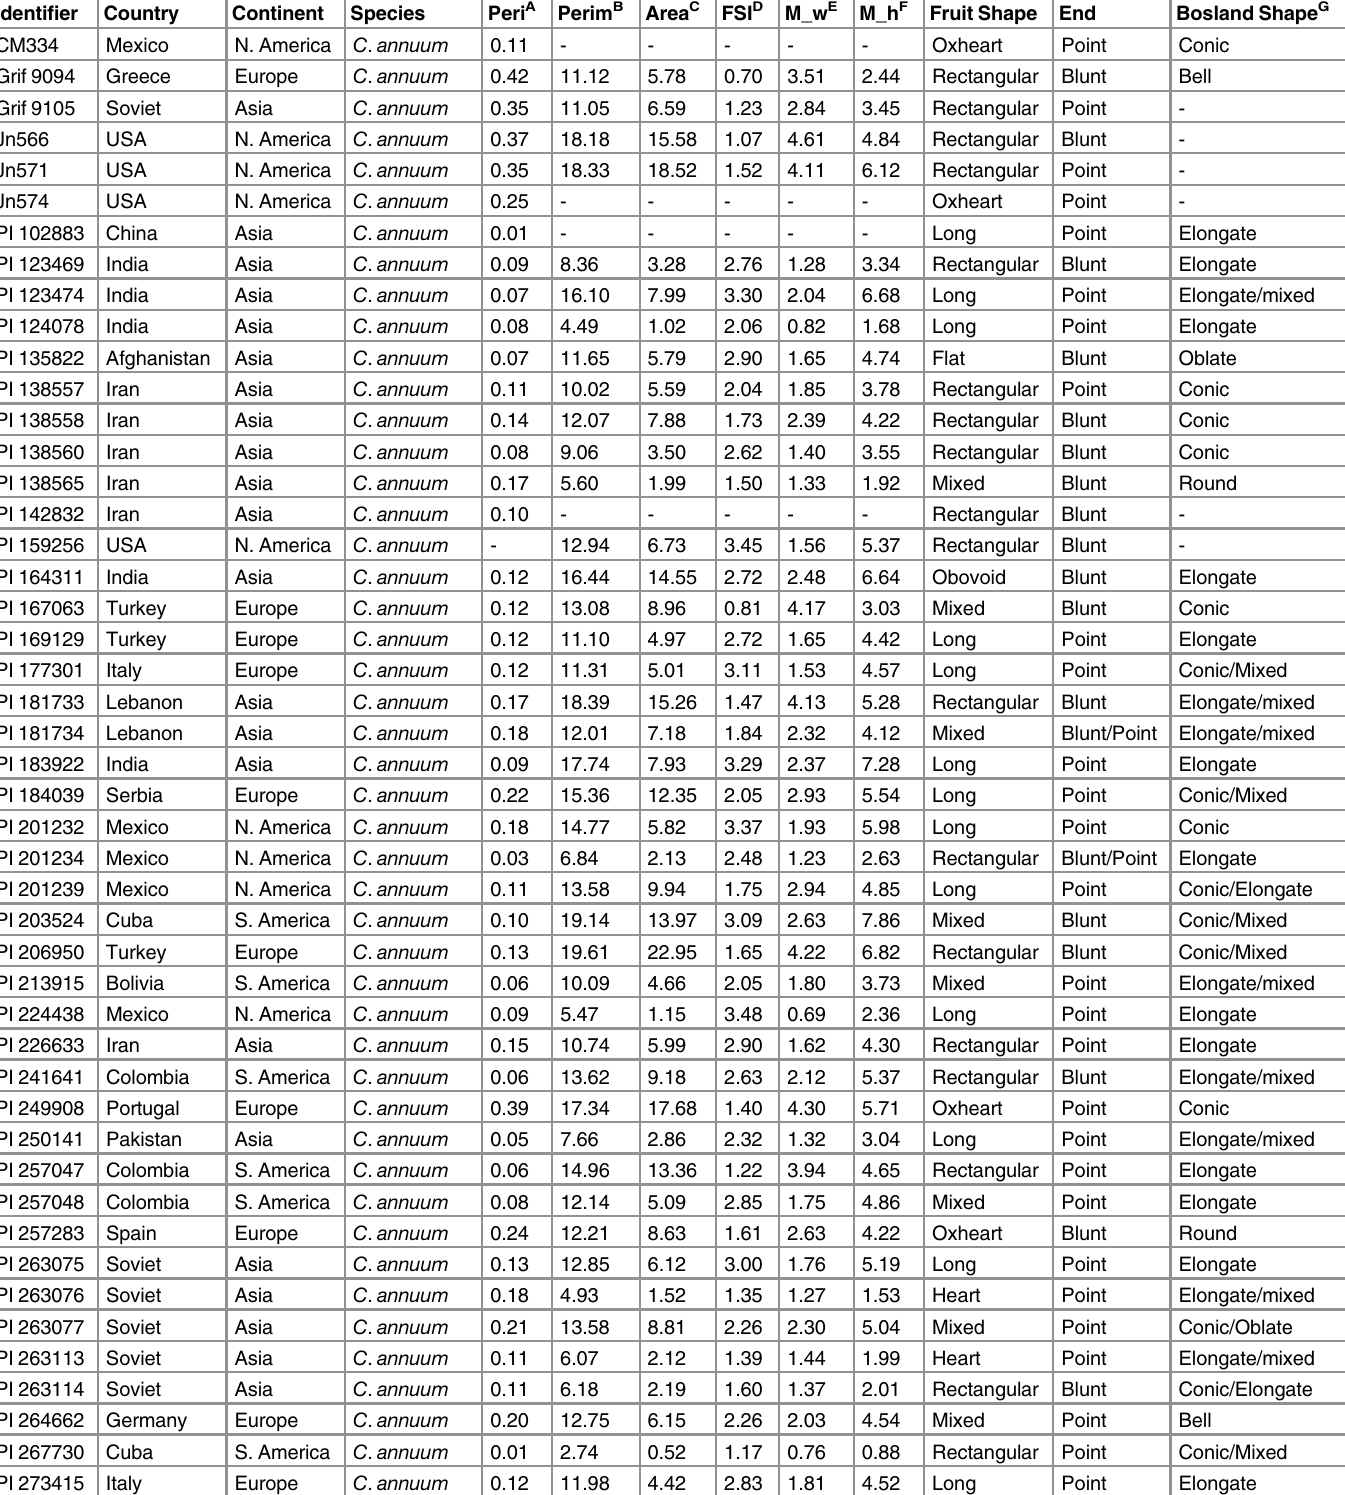
Table 1. Pepper lines evaluated for fruit